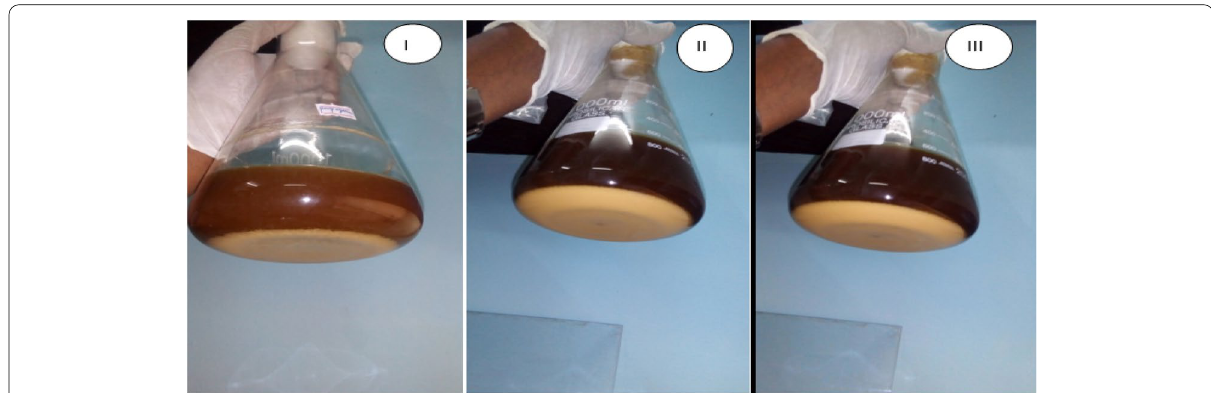
Fig. 3 M. caribbica isolate MJTm3 propagation at different concentrations of molasses propagation medium (MPM) containing 8 °Bx (phase 1), 10 °Bx (phase 2), and 12 °Bx (phase 3) at 24-h propagation